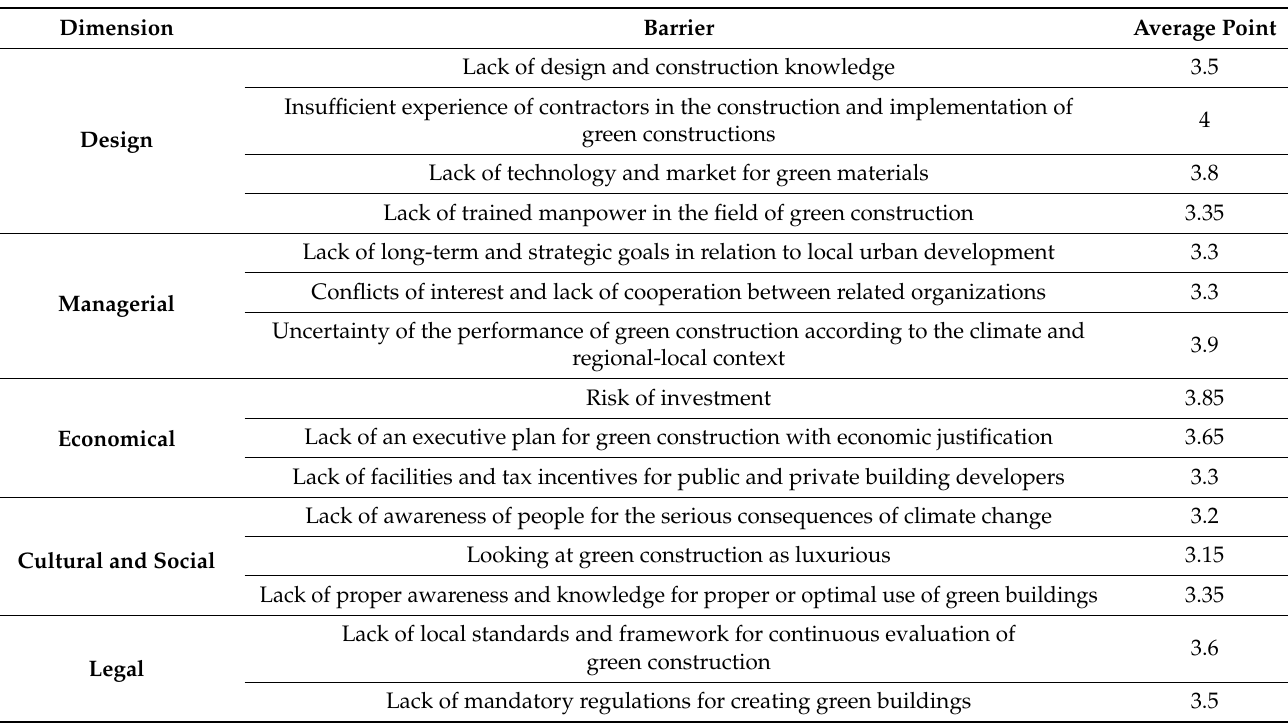
Table 3. Evaluation of our factors based on different dimensions.